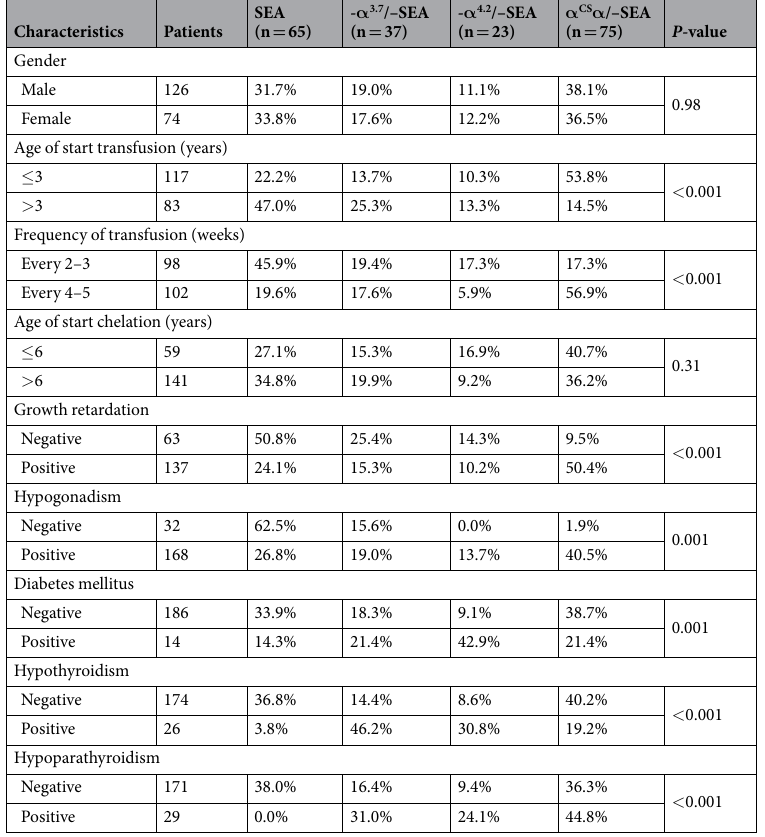
Table 2. Association between patient genotype and endocrinal